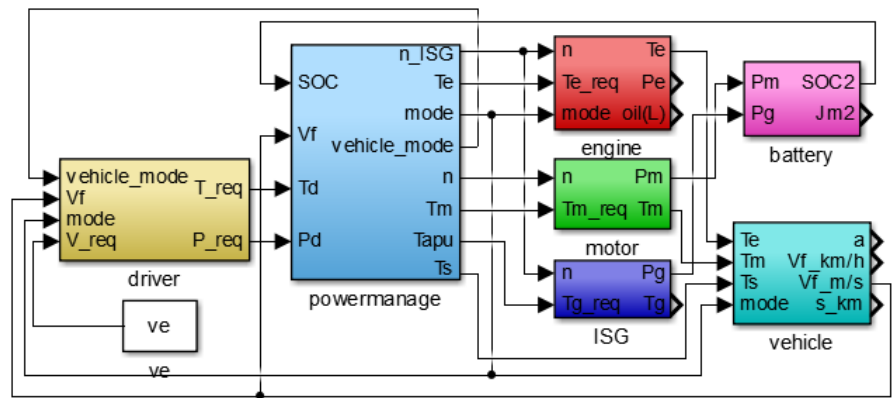
Figure 5. The simulation model of